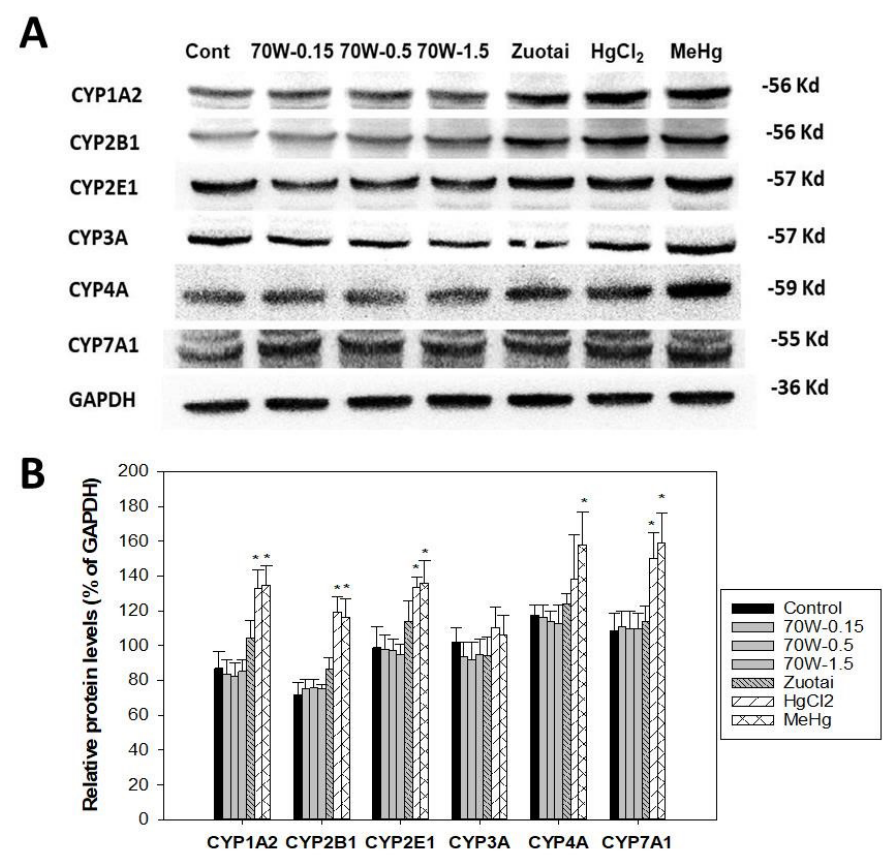
Figure 2. Effect of 70W and mercury compounds on cytochrome P450 isoenzyme protein expression. Mice were given 70W 0.15, 0.5, and 1.5 g/kg, po. Zuotai (30 mg/kg, po), HgCl (33.6 mg/kg, po), and MeHg (3.1 mg/kg, po) daily for seven days, and hepatic proteins 2 were extracted and pooled for Western-blot analysis. A , the representative western-blot; B , statistical analysis of P450 proteins. Data are mean ± SE of 3-5 replicates. *Significantly different from control, p <